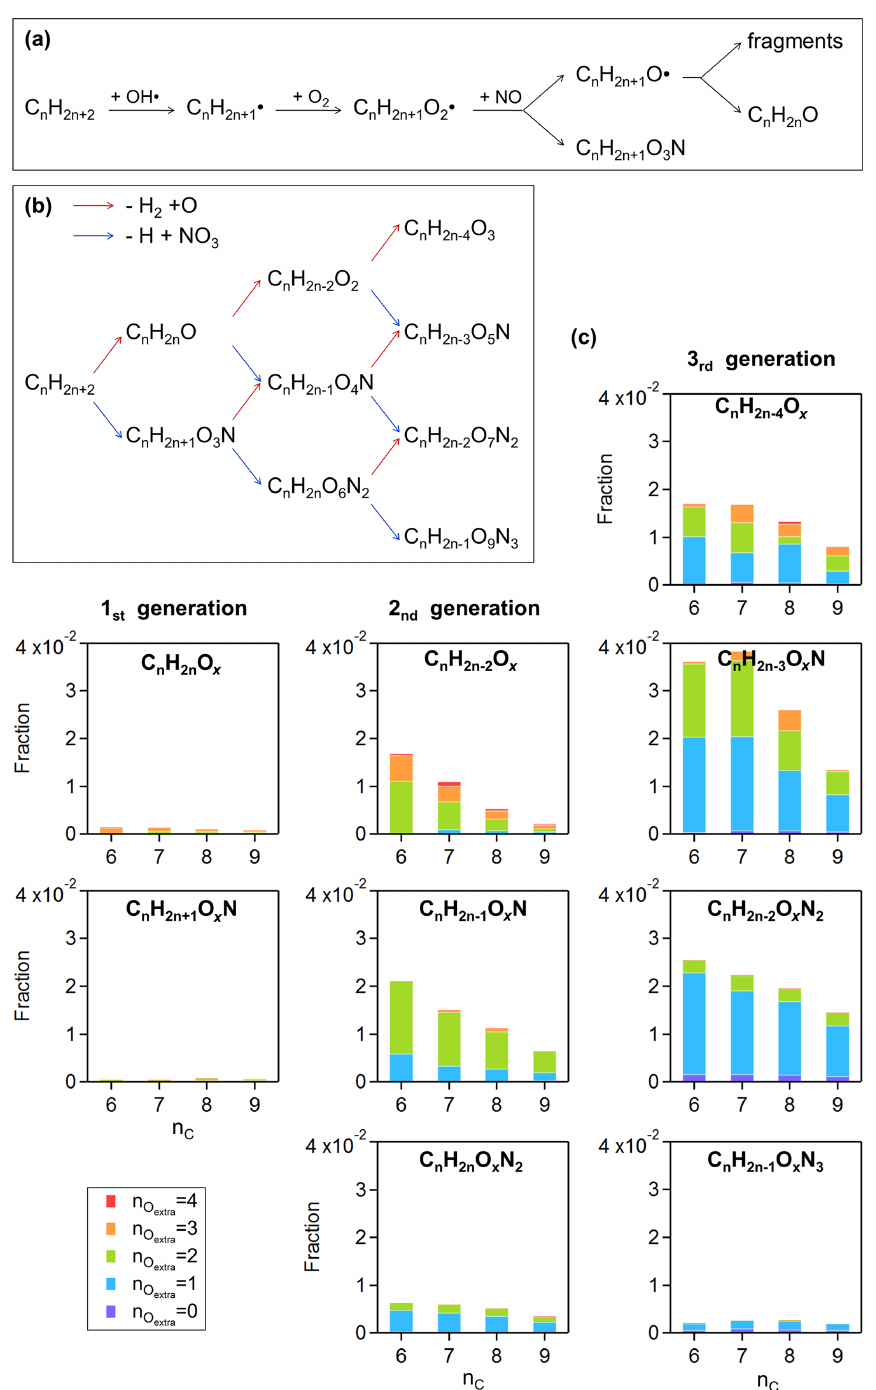
Figure 6. (a) Simplified oxidation mechanism for alkanes attacked by OH once under NO x -controlled conditions. Panel (b) summarizes the changes in the molecular formula of the first- to third-generation products of alkanes, based on the basic reaction scheme in (a) . Panel (c) shows the fraction of potential alkane-derived compounds in the Aliph-OOM factor. The compounds listed in (c) are grouped according to the molecular formulas in (b) , i.e., with the same number of carbon, hydrogen, and nitrogen atoms but different numbers of oxygen atoms. The bars in (c) are colored with n O . Please see text for details about n O extra extra